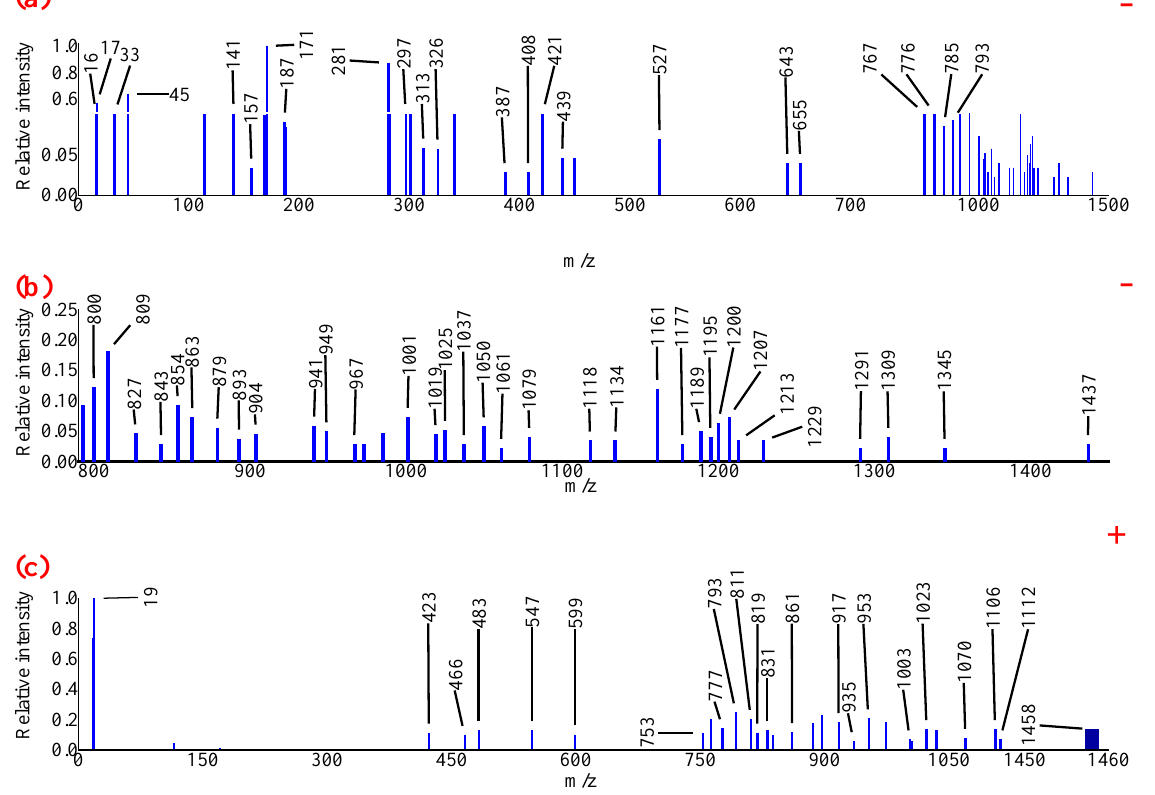
Figure 6. Average mass spectra of dry aged OL particles ( D p >0.3µm): (a) negative ion MS; (b) zoom in plot of figure; (a) and (c) positive ion